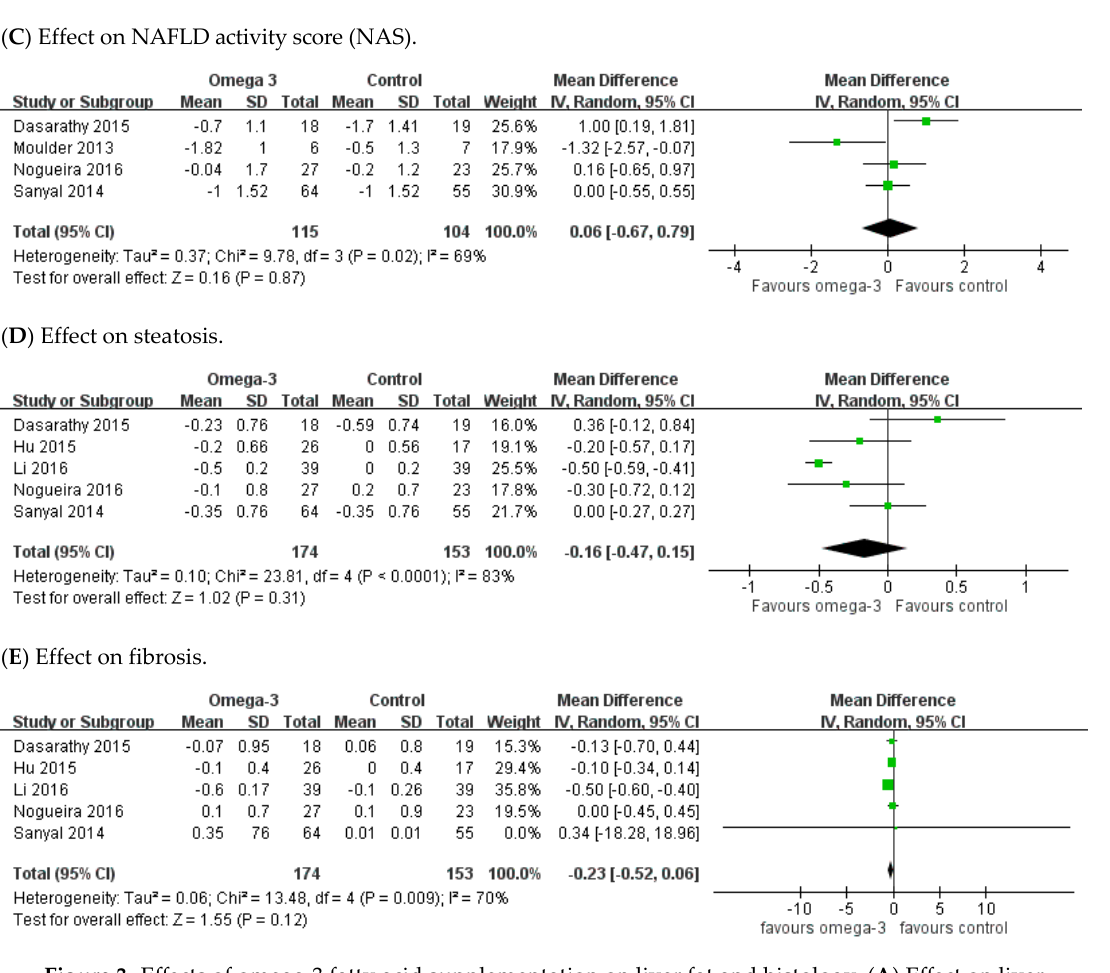
Figure 3. E ff ects of omega-3 fatty acid supplementation on liver fat and histology. ( A ) E ff ect on liver Figure 3. Effects of omega-3 fatty acid supplementation on liver fat and histology. ( A ) Effect on liver fat by sonography and histology. ( B ) E ff ect by proton-density fat fraction. ( C ) E ff ect on NAFLD score fat by sonography and histology. ( B ) Effect by proton-density fat fraction. ( C ) Effect on NAFLD score (NAS). ( D ) E ff ect on steatosis. ( E ) E ff ect on (NAS). ( D ) Effect on steatosis. ( E ) Effect on steatosis.